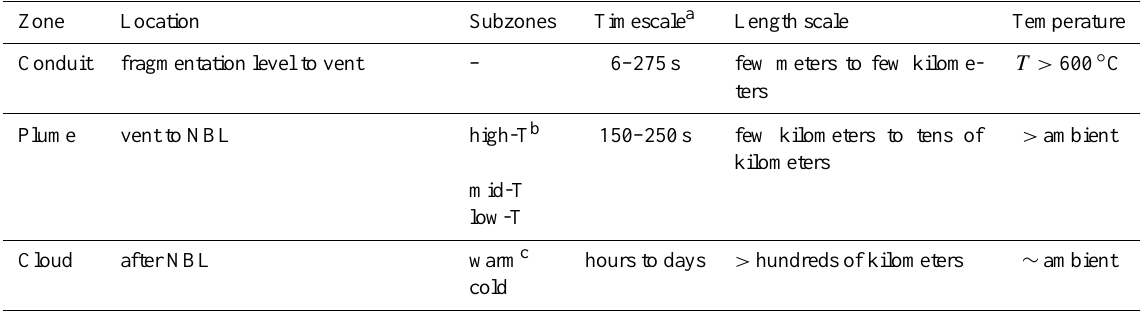
Table 1. Different zones of the plume that affect the fine ash during a plinian and subplinian volcanic eruptions. Zone